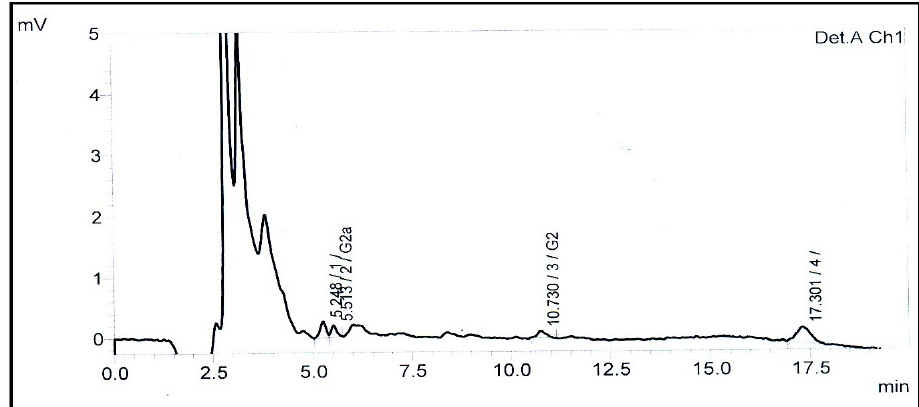
Figure 3. Typical chromatogram of uninfected wheat porridge processed food (sample shows undetectable amounts of